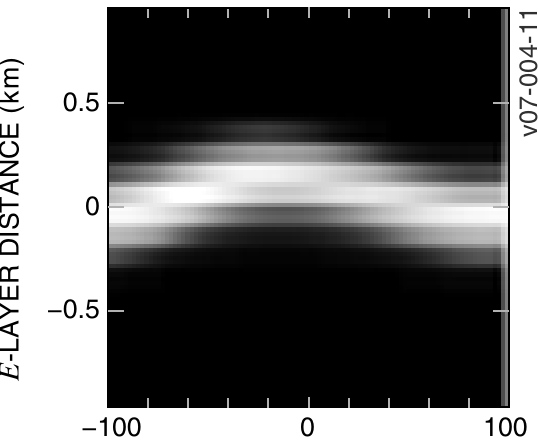
Figure 7: The t = 60 minutes panel of Figure 6(a) with the ordinate scale magnified 100 times, showing the E evolution in the linear regime. The boundary conditions are periodic in the horizontal direction.